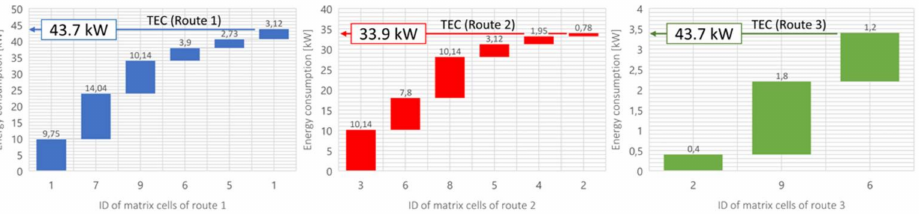
Figure 9. The distribution of energy consumption in each in-plant supply route (TEC = total en- ergy consumption).